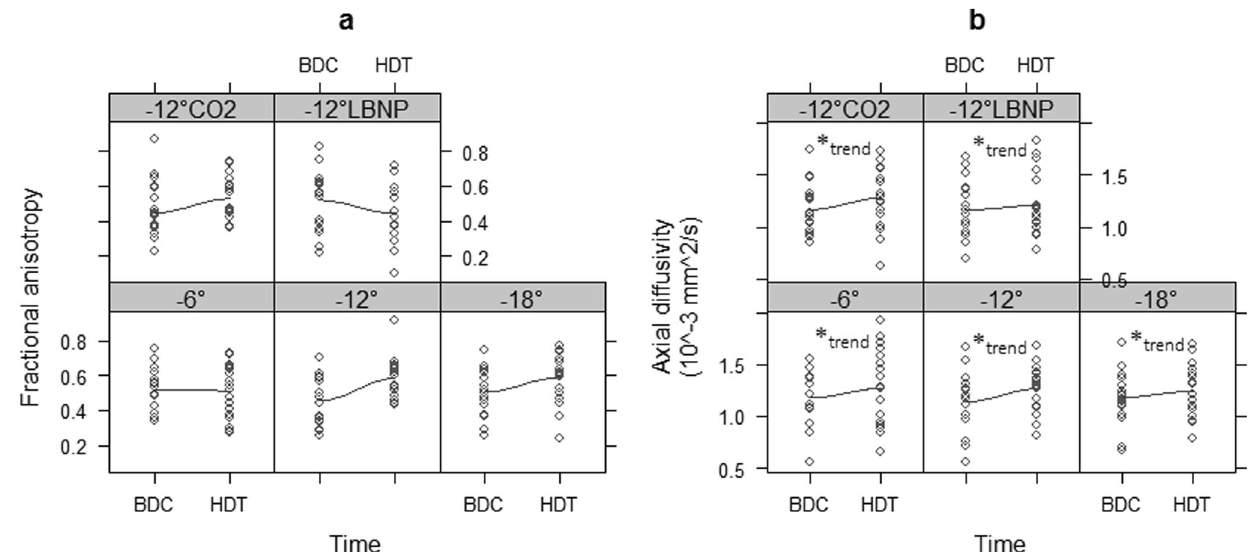
Fig. 4 ON diffusion parameters including FA a and AD b for all conditions ( − 6°, − 12°, − 18°, − 12° and CO 2 , − 12° and LBNP) compared with the corresponding baseline value. Asterisks indicate signi fi cance level from LME corresponding to time effect: *( P =